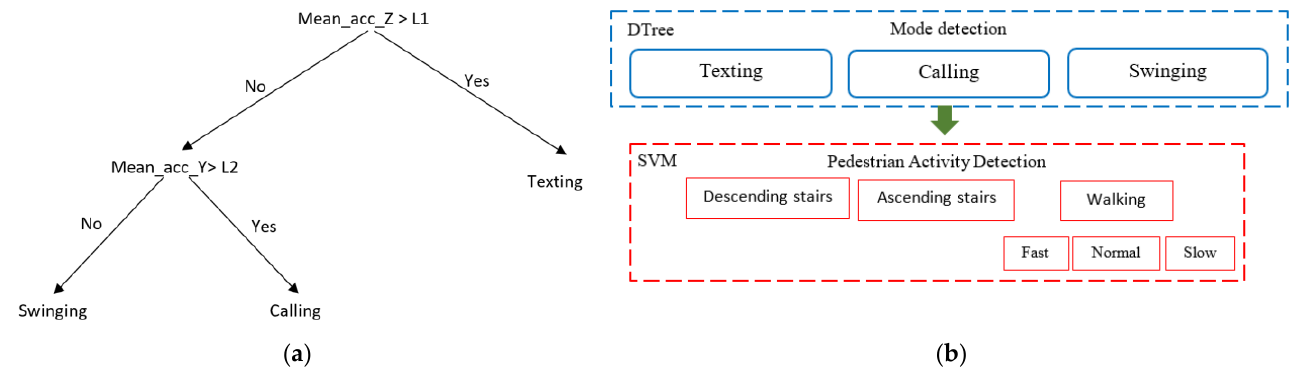
Figure 8. ( a ) DTree Model; ( b ) The combination of DTree and SVM to recognize motion states.